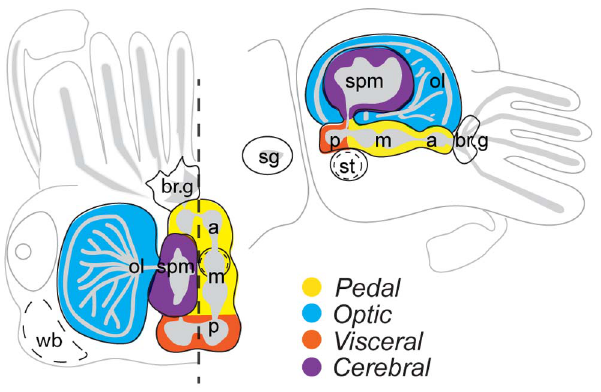
Figure 1. Schematic diagram of the cuttlefish CNS. The molluscan ganglia origin of each principle lobe of the central nervous system (CNS) is color coded. On the left the head is shown from a dorsal view, with the right supraesophageal mass (SPM) removed at the mid- line (dashed line). The CNS is represented in lateral view on the right. The grey neuropil structure is approximate and not meant to represent the actual internal structure of the organ. a: anterior subesophageal mass; br.g: branchial ganglia; m: middle subesophageal mass; ol: optic lobe; st: statocyst; p: posterior subesophageal mass; sg: stellate ganglia; spm: supraesophageal mass; wb: white